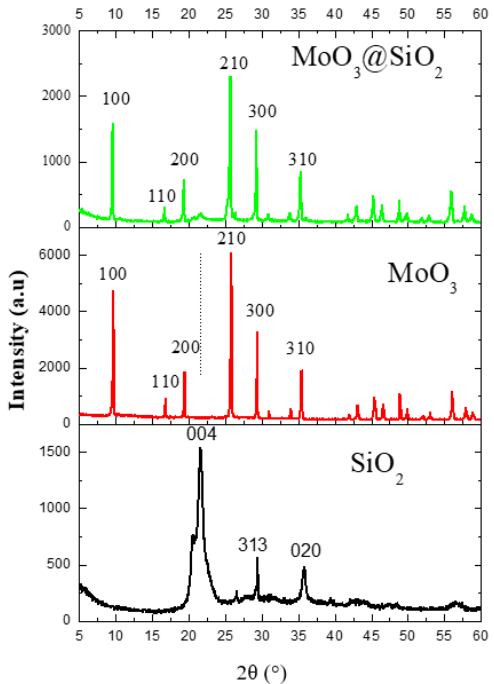
Figure 2. The XRD patterns for the SiO 2 , MoO 3, and the MoO 3 @SiO 2 composite.